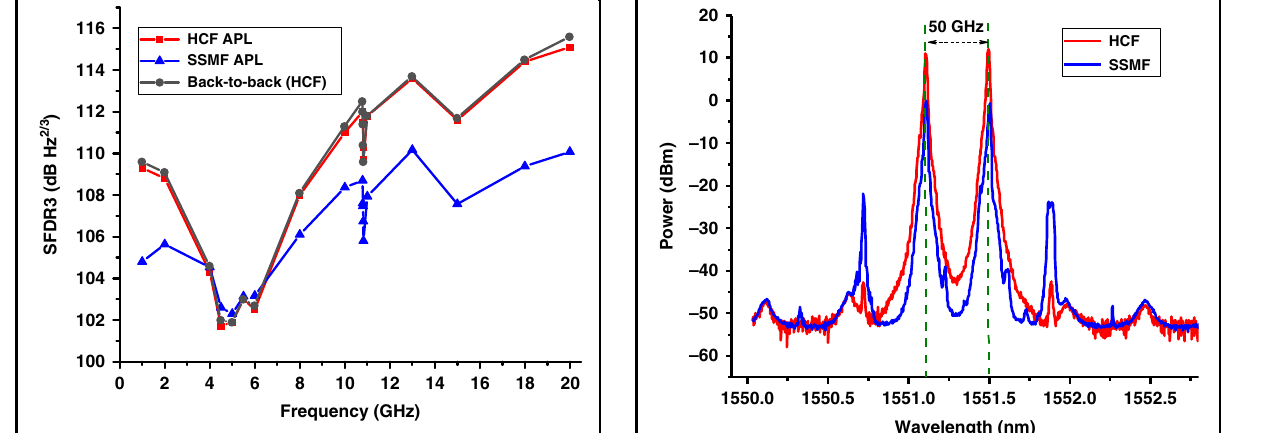
Fig. 9 Measured FWM inside 7.7 km of HCF (red) and 7.4 km SSMF (blue). Two CW laser signals with wavelengths 0.4 nm (50 GHz) apart (their absolute wavelengths are marked with green dashed lines), each with 27 dBm power, are launched into the respective fi bres. The output shows FWM products as new signals 50 GHz apart from the two input signals, They are about 20 and 55 dB weaker than the original signals in the SSMF and HCF cases, respectively, showing signi fi cantly weaker FWM interaction in the HCF as compared to the SSMF